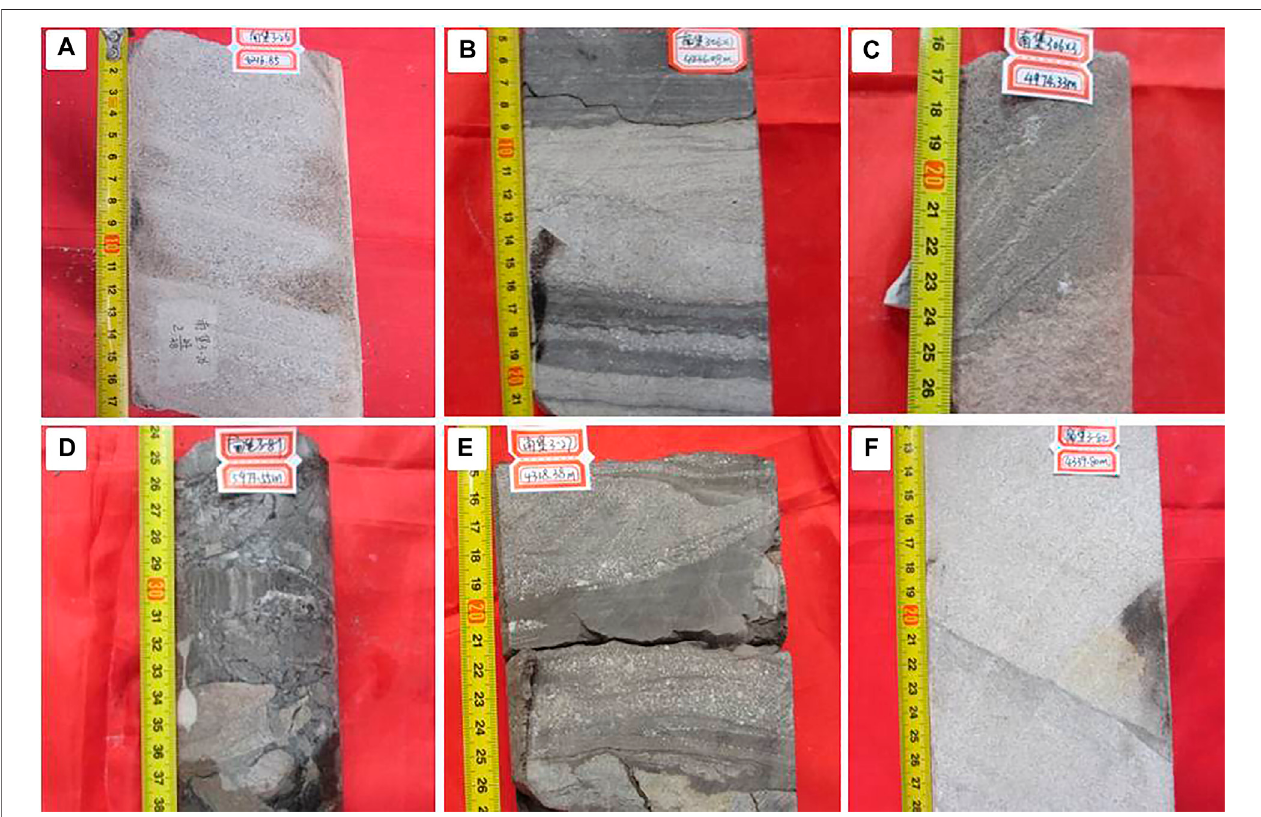
FIGURE4| Lithofaciesmarksofthemiddleanddeep layersintheNanpu No.3structuralarea: (A) NP3-26 (4,216.85 m),positiverhythm coarse sandstonegravel in the main body of underwater distributary channel in the braided river delta front; (B) NP306 × 1 (4,236.08 m), greyish black gravelly mudstone and grayish white sandstoneintheunderwaterdistributarybayofthebraidedriverdeltafront; (C) NP306 × 3(4974.33 m),greymediumsandstoneofestuarydaminthebraidedriverdelta front; (D) NP3-81 (5,973.55 m), grey black mudstone interbedded with gravel in the braided river delta front; (E) NP3-27 (4,318.94 m) deep-water slump turbidite fan with mudstone bands in the grey pebbled sandstone of the agitated structure; (F) NP3-82 (4,339.8 m), grayish white medium sandstone of the beach bar.